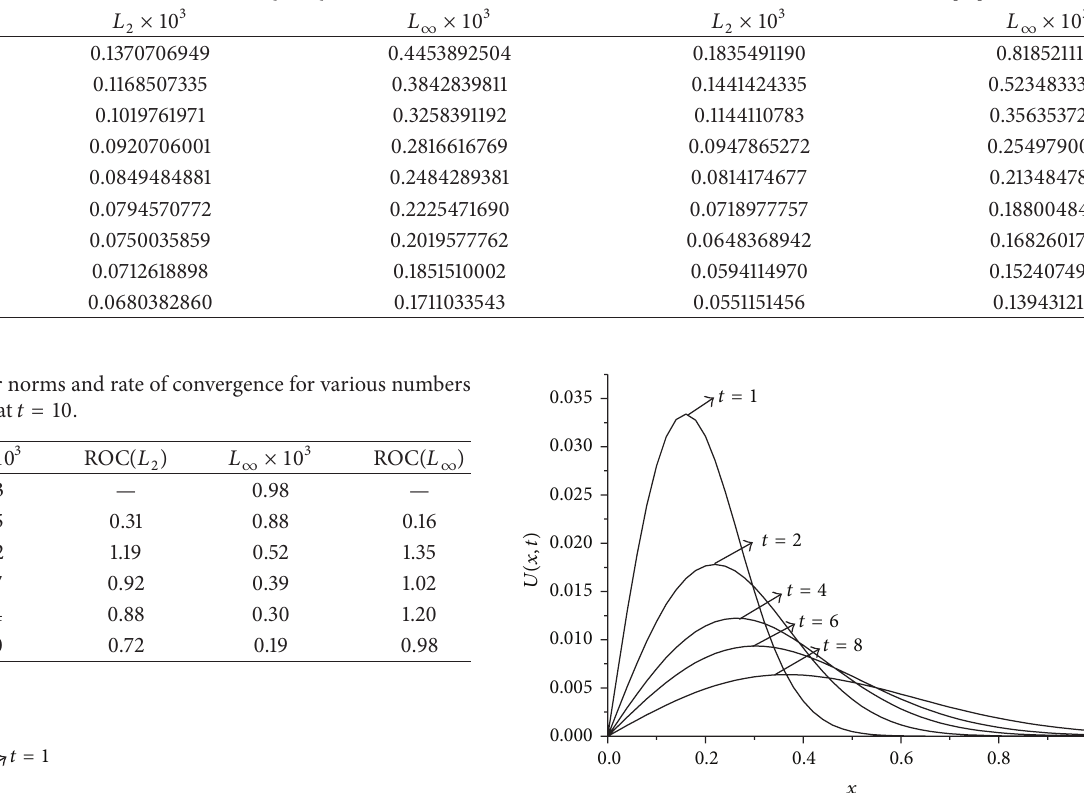
Figure 3: Solution behavior of the equation with ℎ = 0, 02 , 𝑡 = 0,01 , and V = 0.01